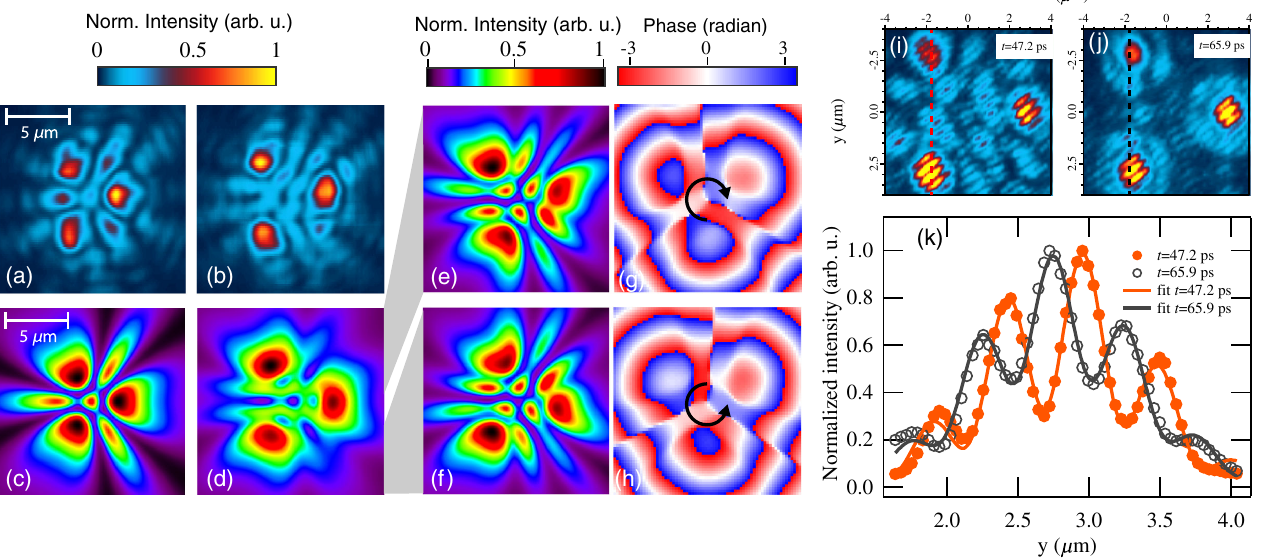
FIG. 5. (a – d) Time-integrated real-space tomography images of the triangular array condensates are shown for a ¼ 4 μ m (a) and a ¼ 5 . 5 μ m (b). The real-space scale bar of (a) also applies to (b). (c,d) Simulations of the Ginzburg-Landau equation with random initial phase, averaged over 75 realizations at different separations matching the experimental conditions are shown. In (c), all three condensates are in phase. In (d), we plot the average of vortices with (cid:1) 1 winding numbers shown in (e) and (f). The phase diagrams of (e) and (f) are shown in (g) and (h), proving that they are indeed vortex states with winding numbers of þ 1 (h) or − 1 (g). (i,j) The time- resolved interferograms resulting from the interference of neighboring condensates are shown at t ¼ 47 . 2 ps (i) and t ¼ 65 . 9 ps (j). The color bar of (a) and (b) applies to the data of (i) and (j). (k) The intensity profiles of the interferograms along the lines marked by the vertical lines in (i) (dashed red) and (j) (dashed black) provide a direct experimental observation of the nearly 2 π = 3 phase difference in the two synchronization regimes. The line profiles of (i) and (j) taken at x ¼ − 1 . 9 μ m. The solid lines are the fits by the convolution of a Gaussian function with cos ð ky þ ϕ Þ resulting in a ð 0 . 78 (cid:1) 0 . 02 Þ × π phase difference between the two